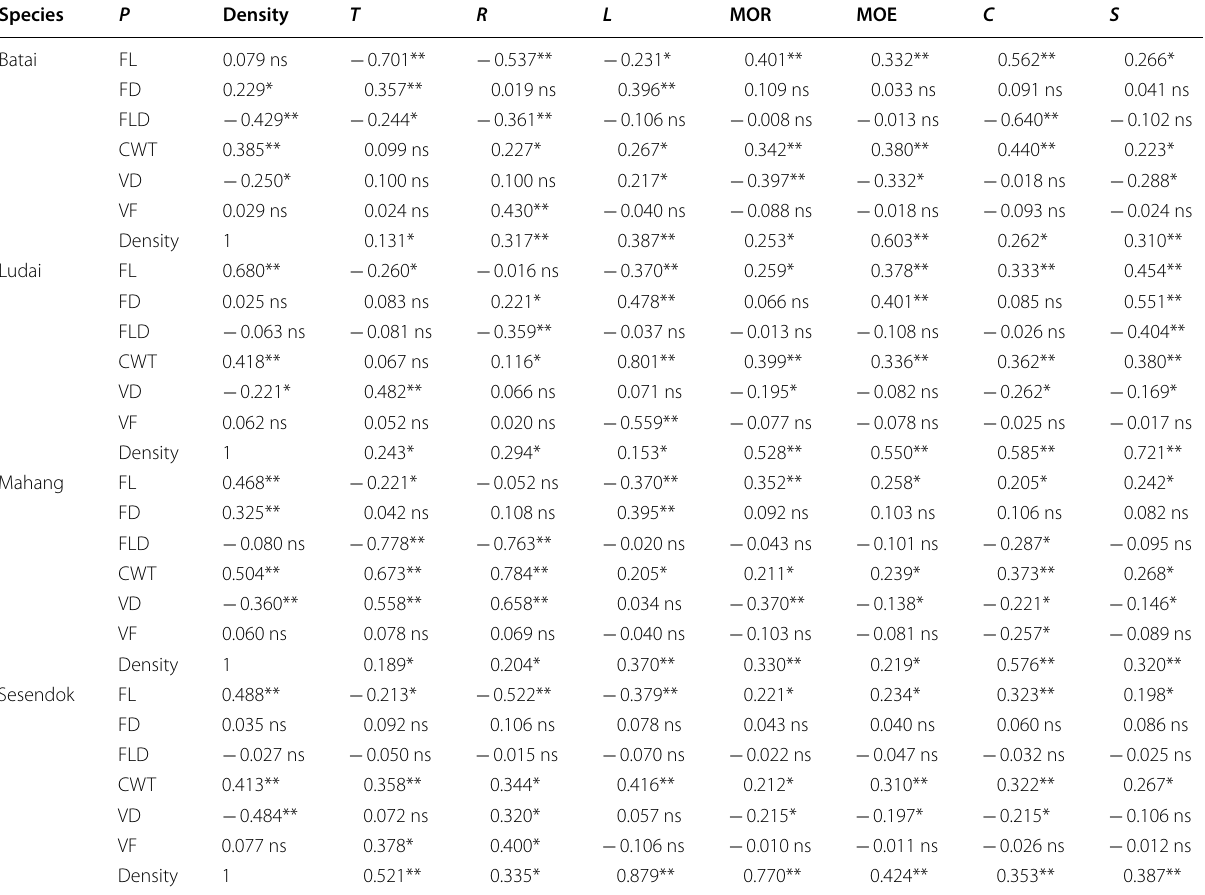
Table 3 Correlation factors influencing density, shrinkage and mechanical properties of batai, ludai, mahang, and